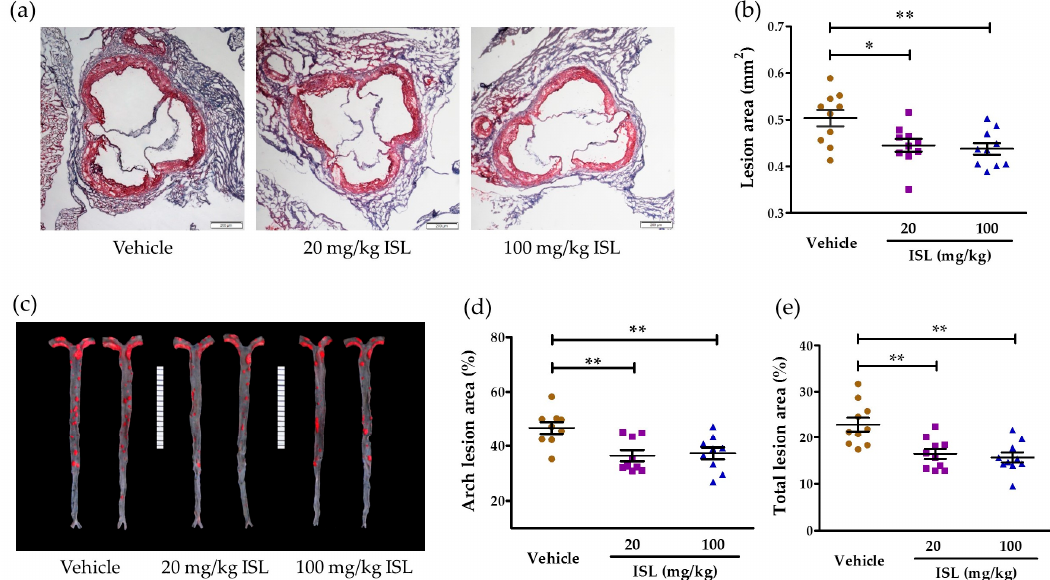
Figure 4. Atherosclerotic lesion areas in the aortic root and aorta en face of apoE − / − mice. ( a ) Representative atherosclerotic lesions of the aortas examined using oil red O-stained cross-sections of the aortic root (8 μ m serial sections, 40×); ( b ) quantitative analysis of the cross-sectional lesion areas of the aortic roots; ( c ) representative en face aortas’ images; ( d ) the percentages of lesion area in the aortic arch; ( e ) total lesion areas analyzed using the Mann – Whitney test ( n = 9–10; * p < 0.05, ** p < 0.01 aortic arch; ( e ) total lesion areas analyzed using the Mann–Whitney test ( n = 9–10; * p < 0.05, ** p < 0.01 vs. vehicle group). vs. vehicle